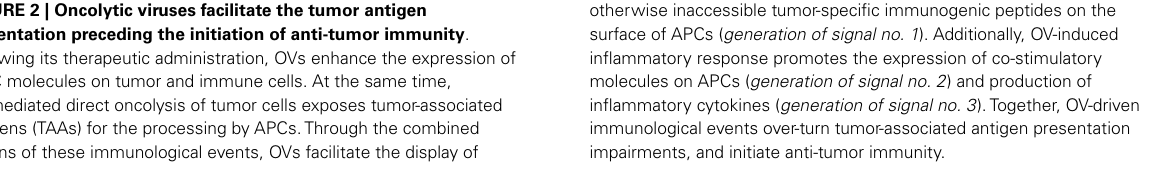
otherwise inaccessible tumor-specific immunogenic peptides on the surface of APCs ( generation of signal no. 1 ). Additionally, OV-induced inflammatory response promotes the expression of co-stimulatory molecules on APCs ( generation of signal no. 2 ) and production of inflammatory cytokines ( generation of signal no. 3 ).Together, OV-driven immunological events over-turn tumor-associated antigen presentation impairments, and initiate anti-tumor